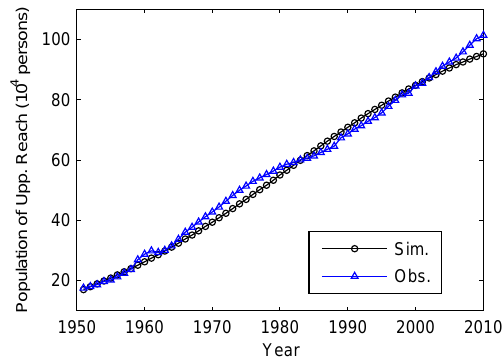
Figure 10. Population of the upper reach of the Tarim River.